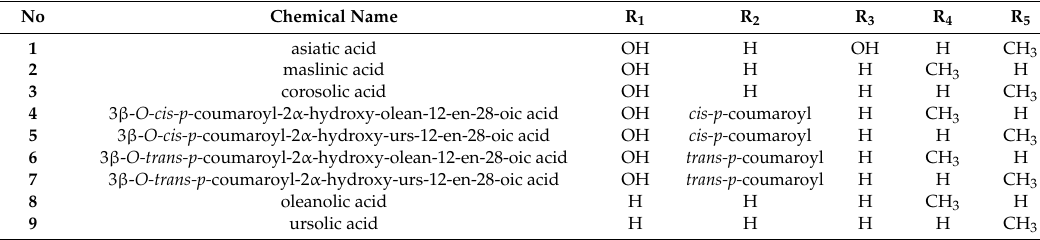
Table 1. Chemical structures of nine triterpenoids from P. guajava